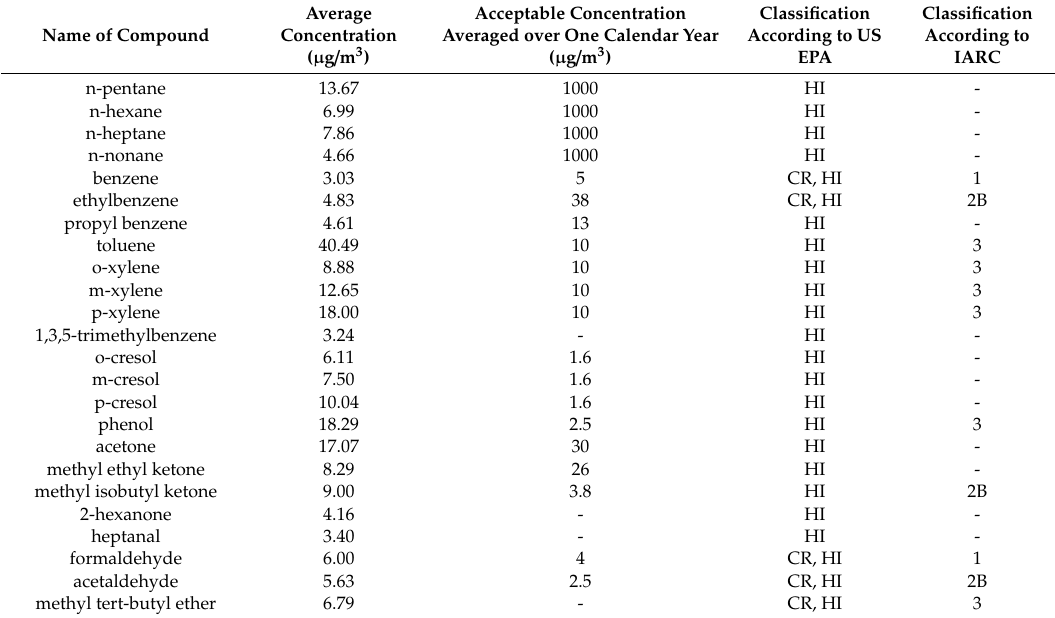
Table 5. Comparison of average concentration of identified compounds emitted during sewage treatment with acceptable concentration levels. Classification of these acompounds according to US EPA and International Agency for Research on Cancer (IARC). Acceptable Concentration Average Averaged over One Calendar Name of Compound Concentration